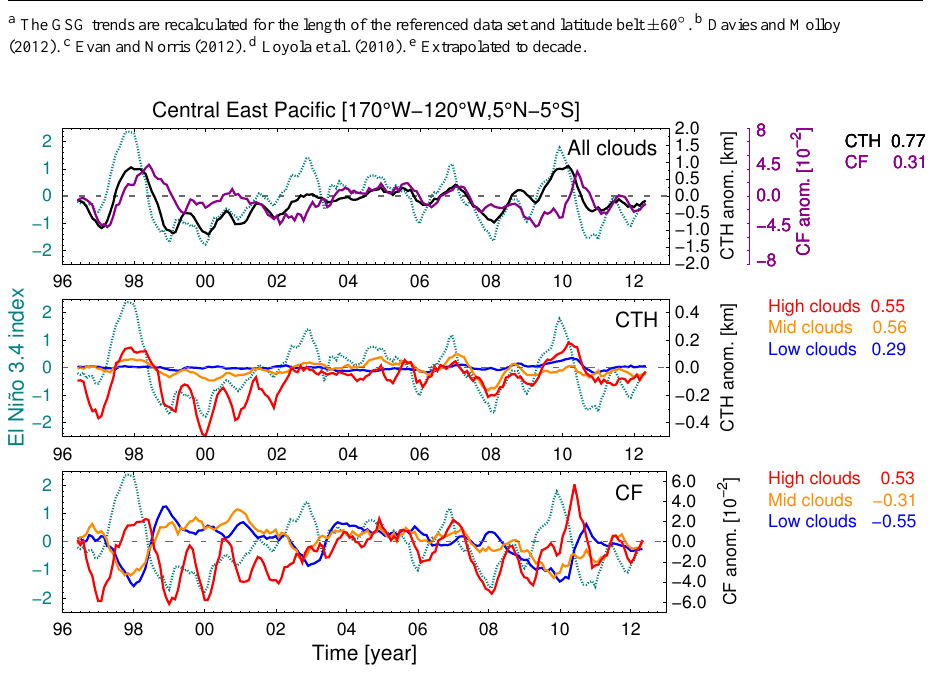
Figure 8. (Top plot) Time series of CTH (black curve) and cloud fraction (purple) anomaly over the central East Pacific with the El Niño 3.4 index and Pearson’s correlation coefficient. (Middle plot) CTH and (bottom plot) CF anomalies subset for low- (blue), mid- (orange), and high-level (red) clouds. Time series smoothed with a 6-month running mean. Correlation coefficients calculated with unsmoothed data.